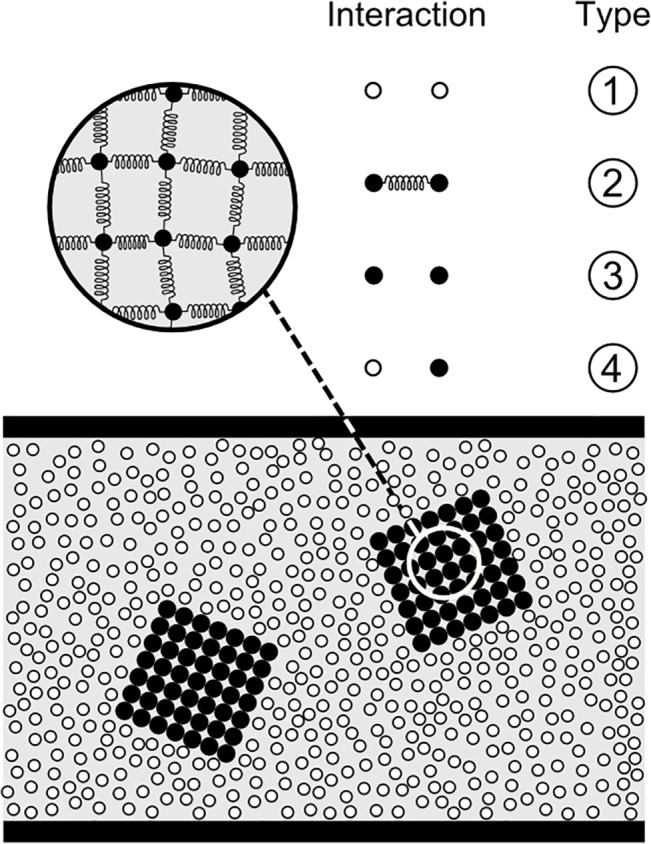
Types of interactions occurring between elemental particles.